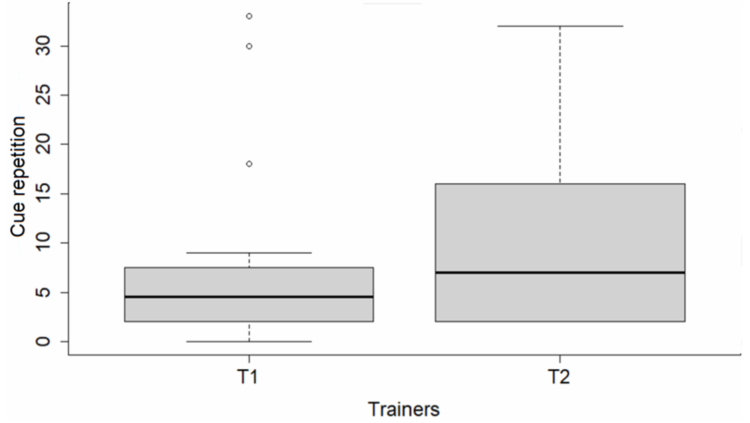
Figure 2. Cue-repetitions in the last training sessions of shelter and companion dogs with Trainer 1 (T1) and Trainer 2 (T2). Bold horizontal lines show medians; gray boxes represent quartiles; thin horizontal lines show minimum and maximum values.